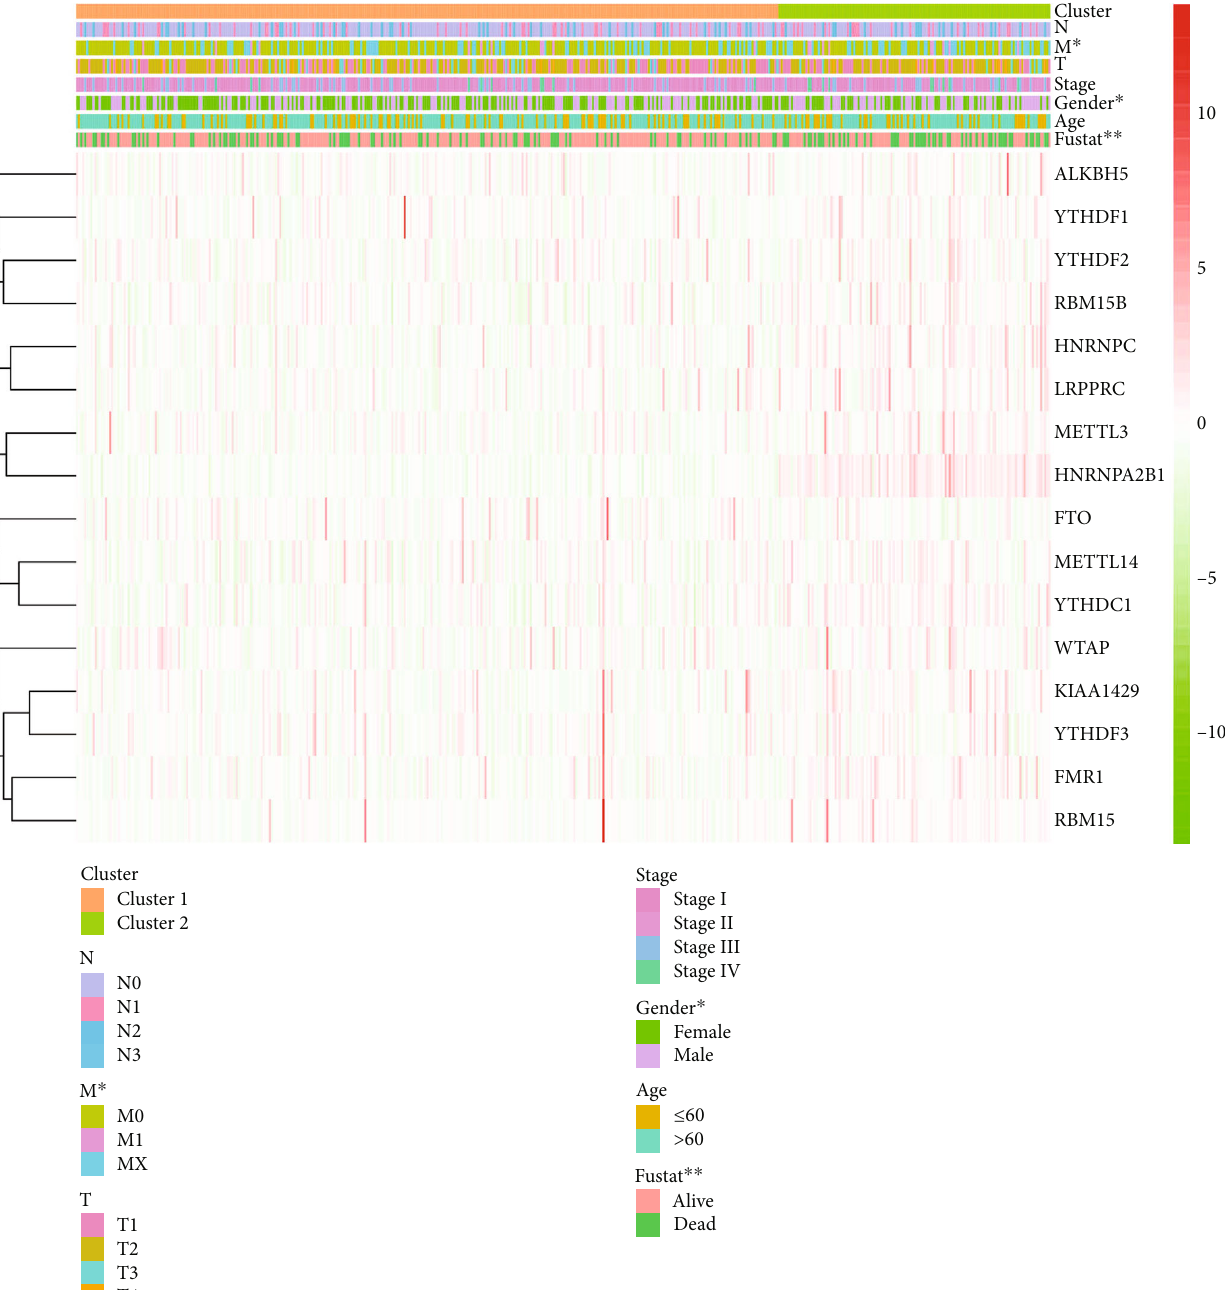
Figure 2: The heat map of clinically associated traits of two clusters. The two clusters signi fi cantly di ff ered in terms of sex, M phase, and survival